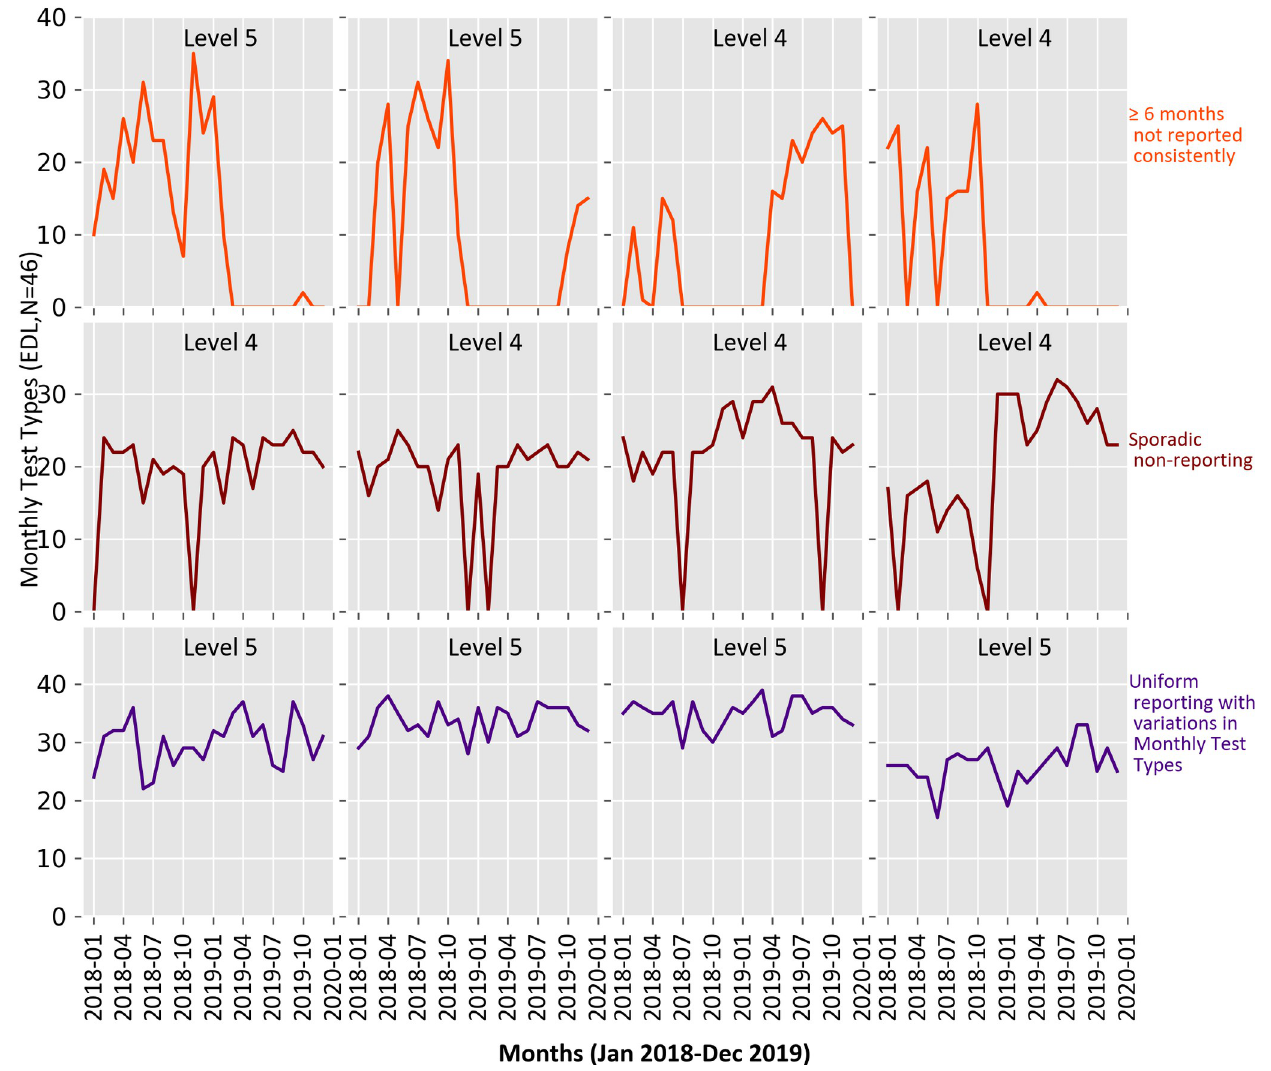
Fig 2. Monthly DHIS2 reporting trends of EDL tests in the year 2018 and 2019. The 4 facilities presented in each category were selected randomly.